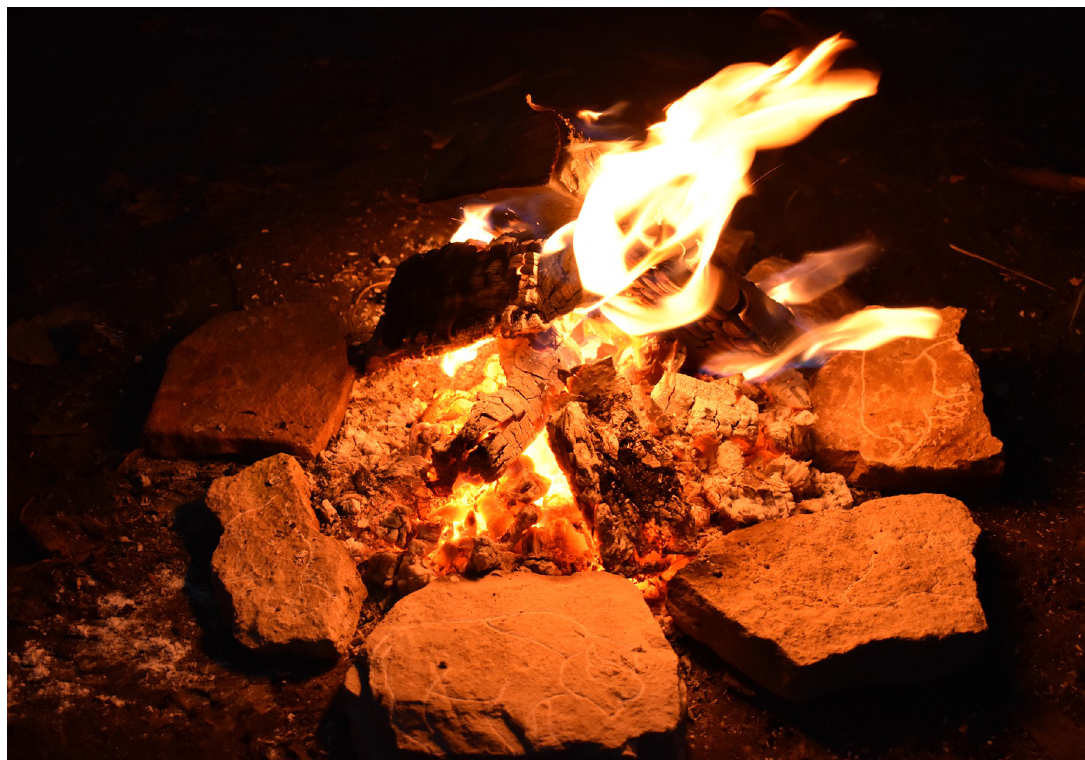
Fig 5. Photograph showing ambient light levels and the position of replica plaquettes in relation to the fire during experiment E.